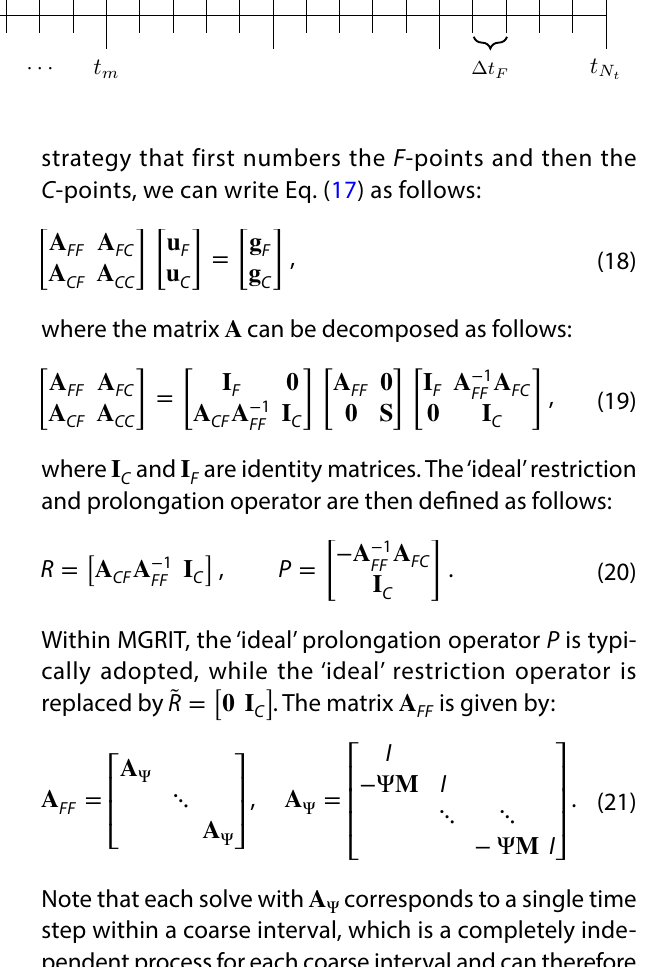
Fig. 2 Coarse and fine tempo- ral mesh from 0 to T , based on Fig 2.1 of